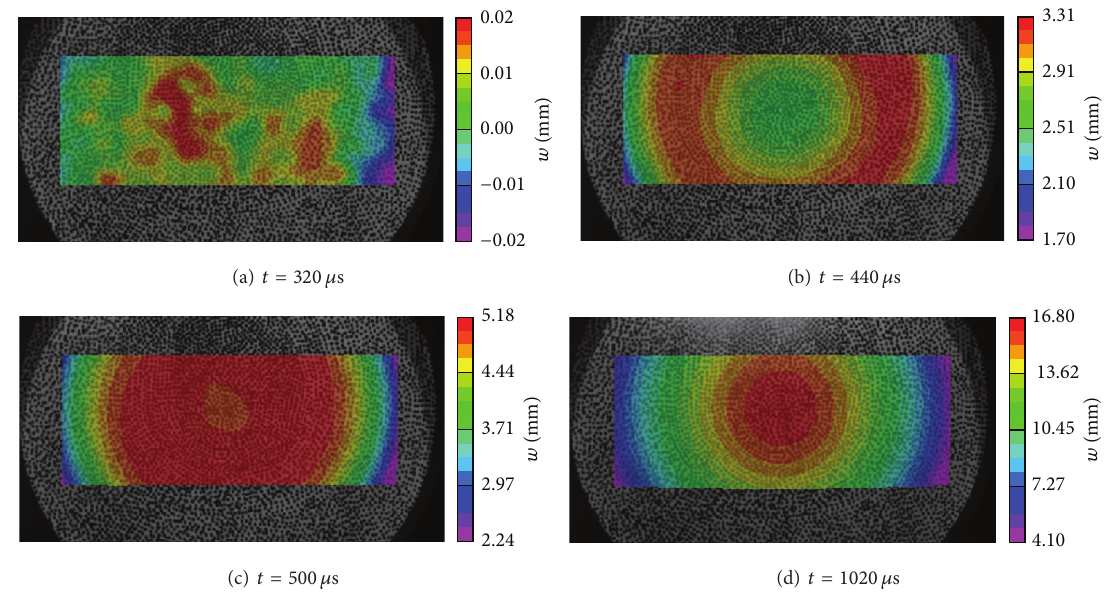
Figure 7: Typical full-field resultant displacements at different time steps for aluminium monolithic plate (3.0mm thick, 𝑉 0 = 97.7 m/s, = 26.0 MPa, 𝜃 = 26.8 𝜇 s, and ̂𝐼 = 0.453 𝑝 𝑚𝑠 0